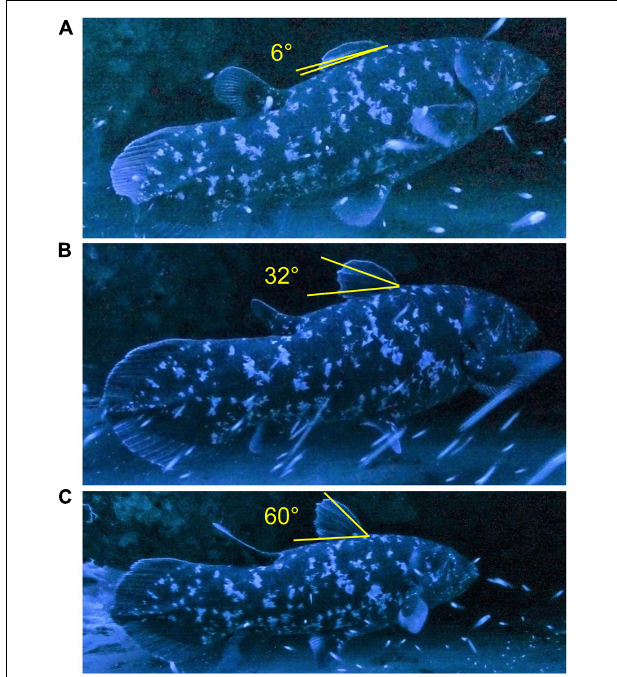
FIGURE 3 | Images of dorsal fin angle of the coelacanth, Latimeria chalumnae , that was recorded in a cave at the upper end of Jesser Canyon off of Sodwana Bay on 11 July 2018 showing the dorsal fin folded when there was no shark present (A) , partly unfolded (B) , and fully unfolded when a shark was present (C)